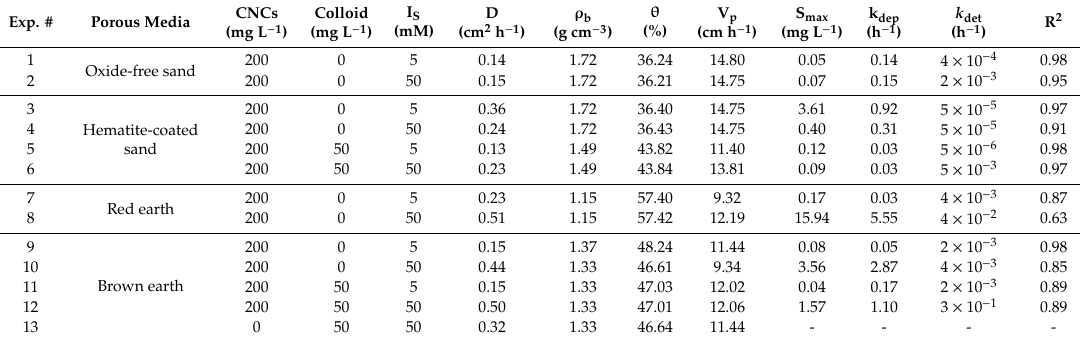
Table 1. Experimental conditions and fitted parameters for column